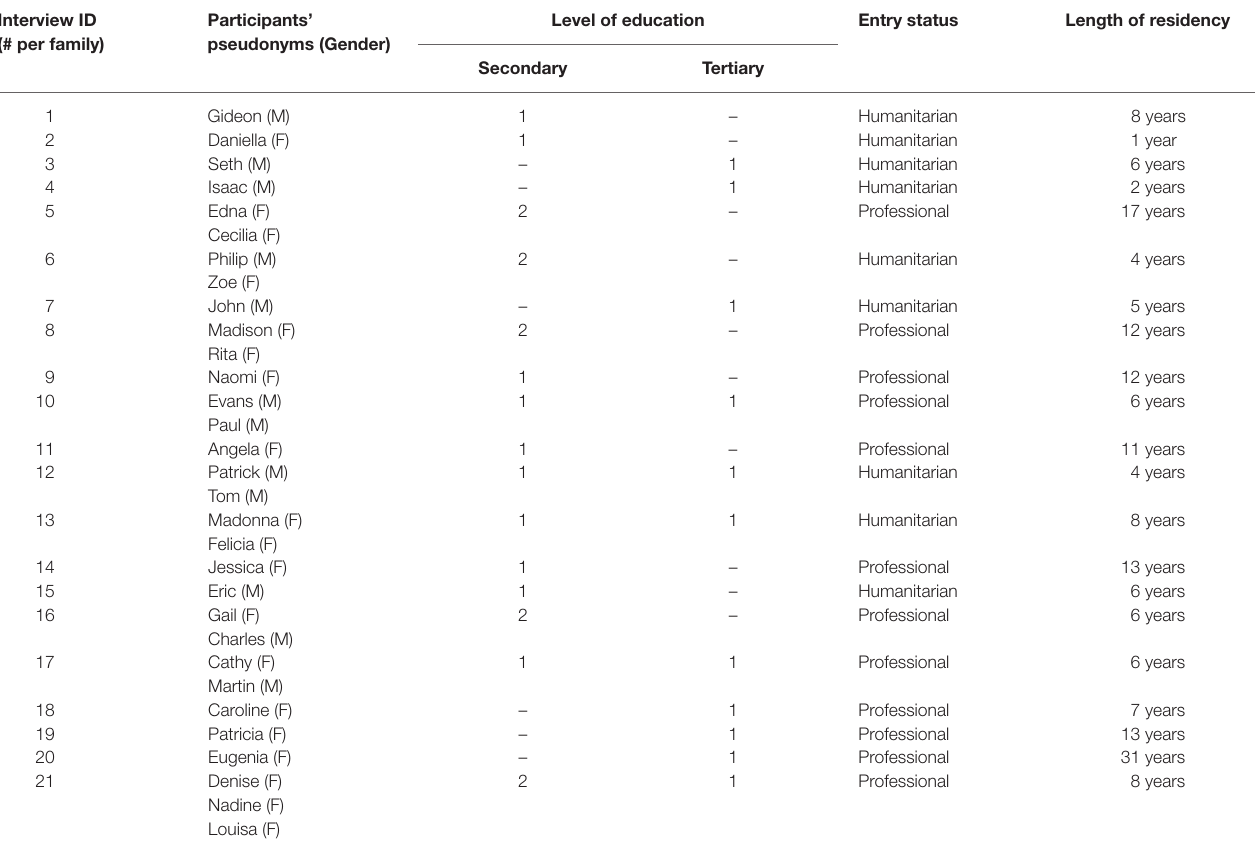
TABLE 1 | Study participants’ profile. Interview ID (# per